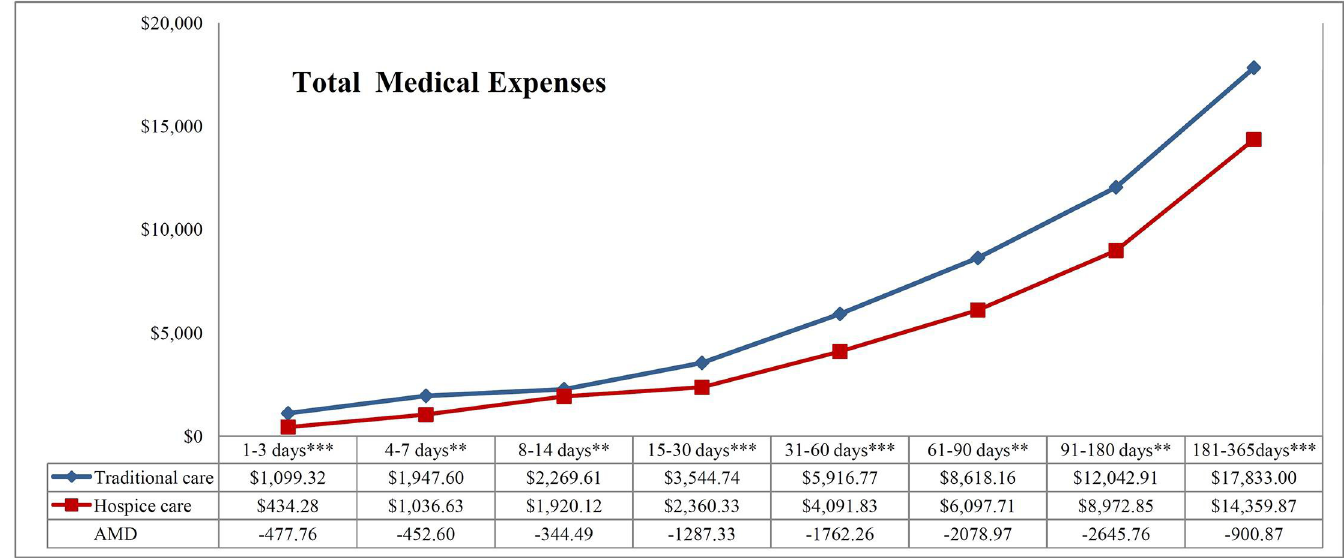
Fig 4. Total medical expenses for traditional care and hospice care. After the average values for the traditional group and the hospice group were calculated by the least-squares means in controlling the treatment of each hospital in each year, the differences between the average values of the hospice treatment and the traditional group were the adjusted mean difference (AMDs). Negative AMD values indicate savings on medical expenses. 1 US dollar = 31 Taiwan Dollars; � p < .05; �� p < .01; ��� p <